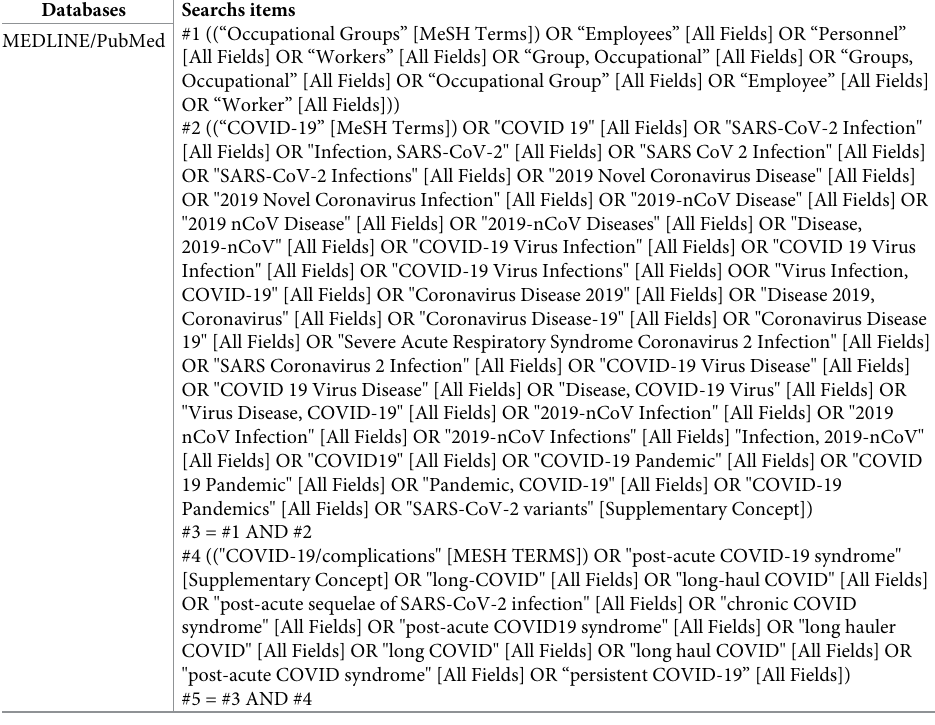
Table 1. Preliminary pilot search strategy in MEDLINE/PubMed.